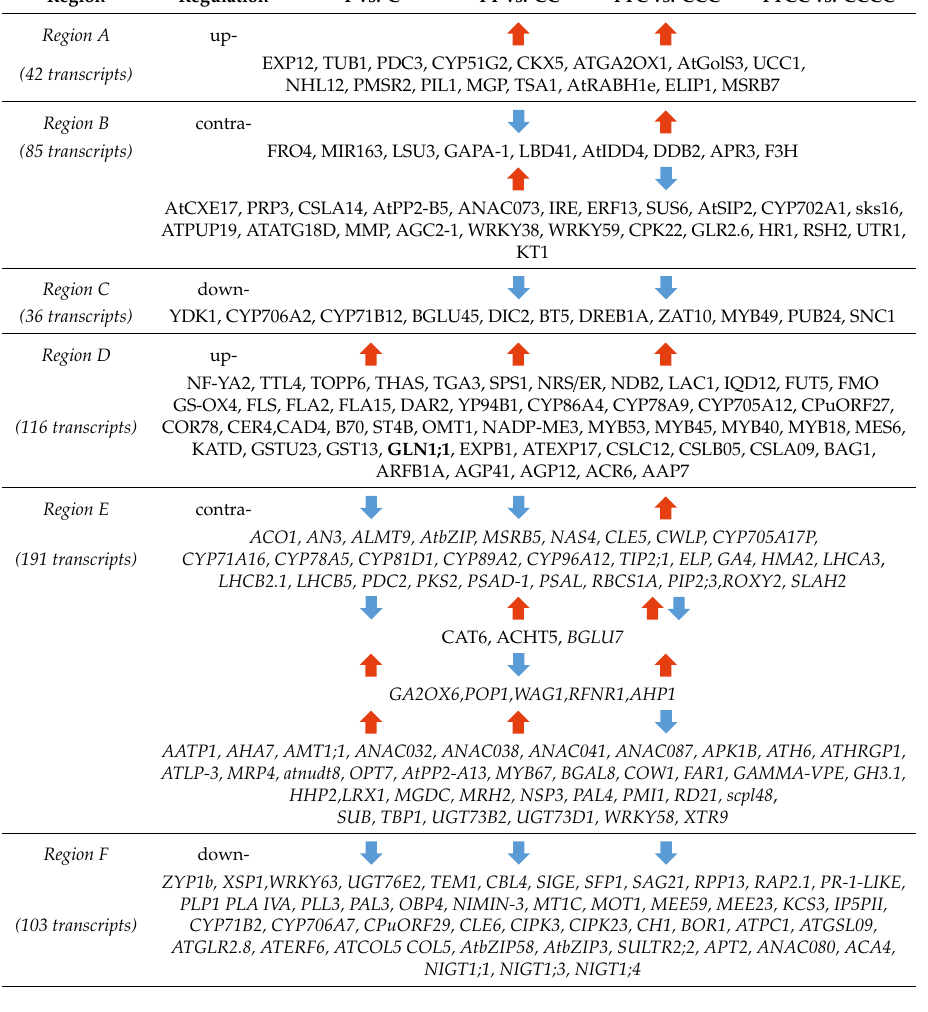
Table 2. Selection of the most annotated transcripts presents in the Venn diagram regions A to F of Figure 5. All significantly modulated transcripts were filtered using Log 2 FC ≥ | 1.00 | as threshold in at least one of the comparisons ( N = 3, q -value < 0.05). Red arrows, upregulated transcripts; blue arrows, downregulated transcripts; transcripts directly involved in N acquisition are shown in bold. For each region, the complete list and annotation of the genes is reported in Table S4. T vs. C